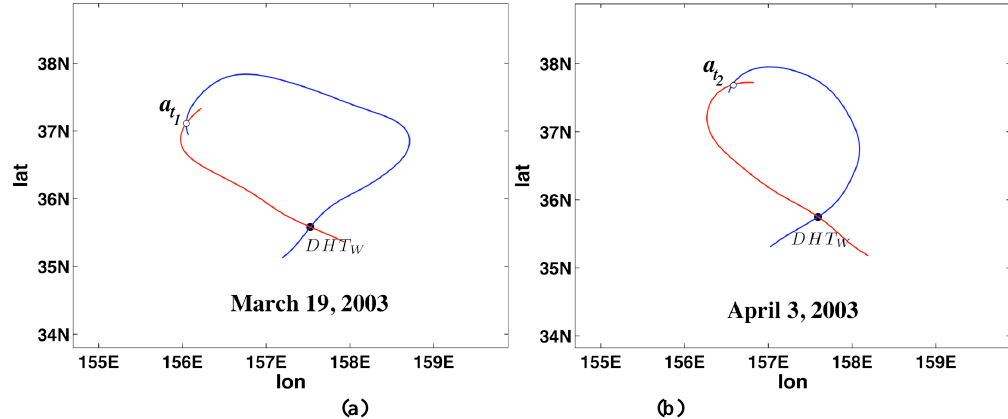
Fig. 18. Lagrangian barriers for the western eddy at dates 19 March and 3 April 2003. These have been made from finite length pieces of the stable and unstable manifolds of DHT W . The boundary intersection points are denoted respectively by a t